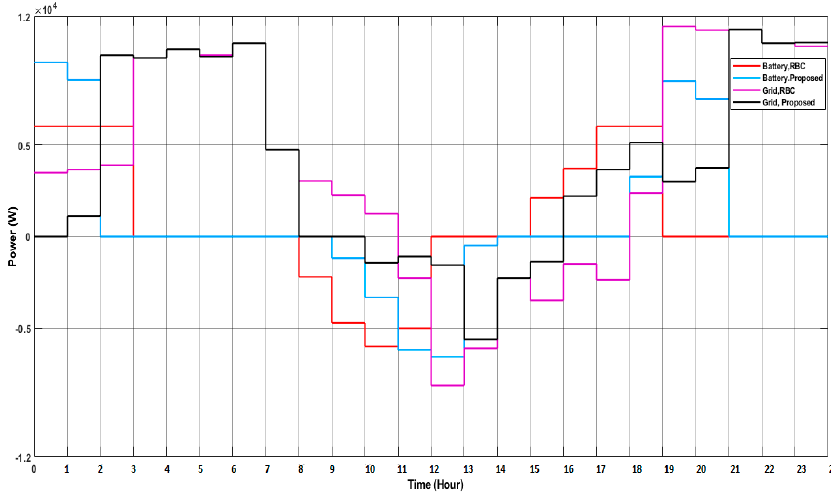
Figure 16. Comparison of battery usage and grid usage.